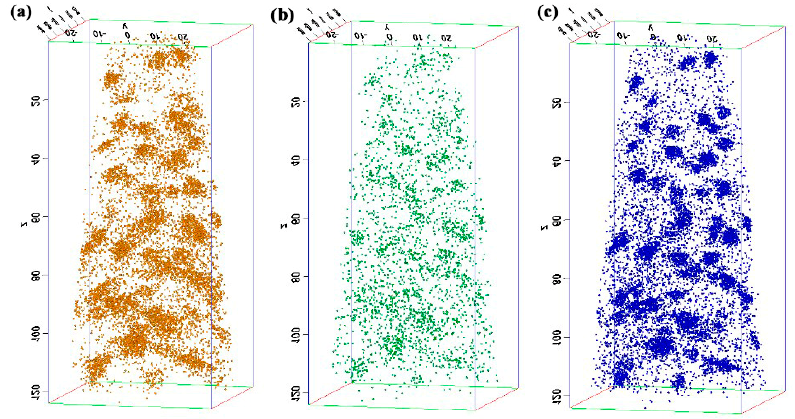
Figure 6. APT 3D atom reconstruction of high-strength steel samples showing distributions of various elements: ( a ) O; ( b ) Ti; and ( c ) Ti-O component.